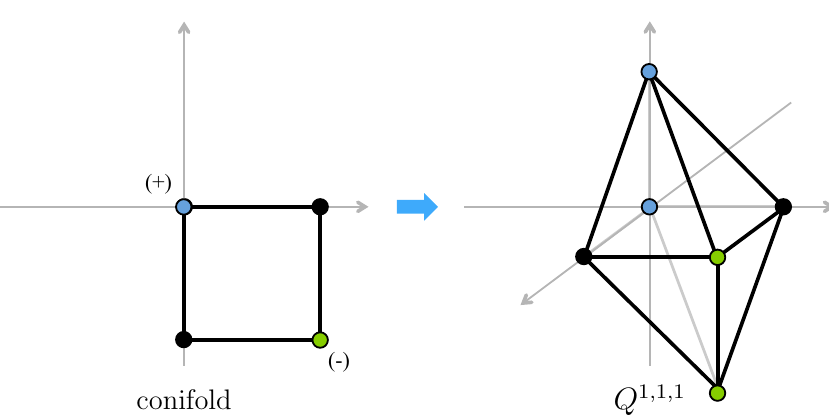
Figure 14. The toric diagram for Q 1 ; 1 ; 1 , obtained by lifting two perfect matchings of the conifold in opposite